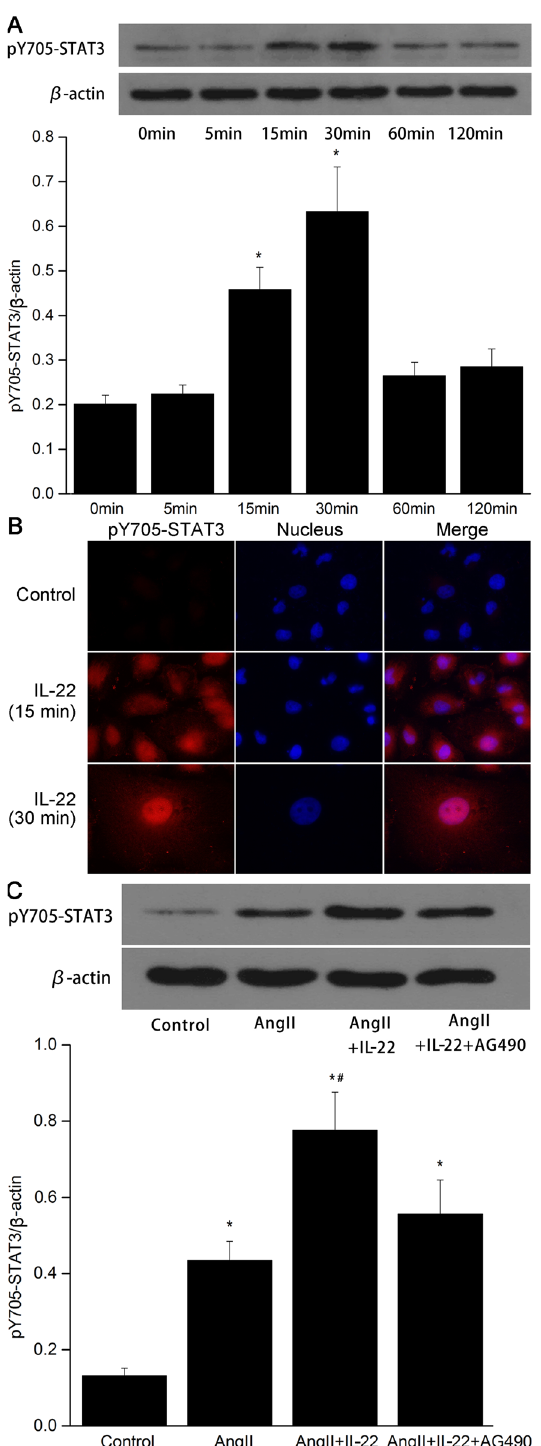
Figure 6. IL-22 significantly stimulated phosphorylation at tyrosine 705 of STAT3 in PMVECs. ( A ) The expression of pY705-STAT3 was up-regulated after IL22 interference, and reached the peak level at 30 min. ( B ) Immunofluorescence analysis indicated the expression of pY705-STAT3 significantly increased together with accumulation in the nucleus after IL22 interference. ( C ) The expression of pY705-STAT3 in the AngII + IL22 group was higher than the other groups. The raw data of Western blot were listed in the Supplementary file. * P < 0.05 versus control group; # P < 0.05 versus AngII group and AngII + IL-22 + AG490